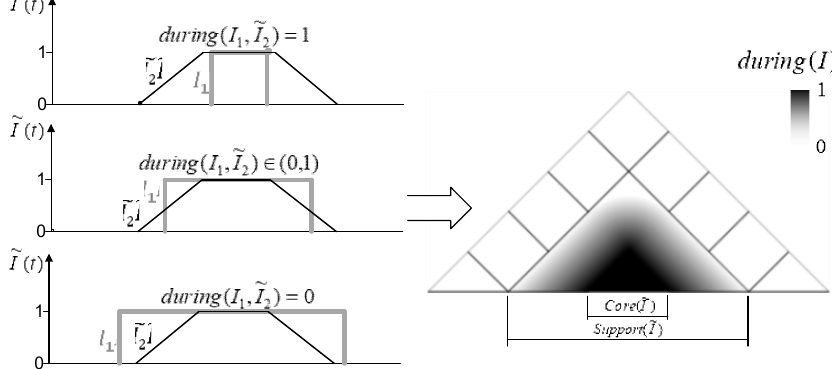
Figure 9. Representing the during relation to a fuzzy time interval (cid:101) I ( t ) in TM (adapted from Figure 9 . Representing the during relation to a fuzzy time interval 𝐼(cid:4634)(𝑡) in TM (adapted from [15]) Figure 9 . Representing the during relation to a fuzzy time interval 𝐼̃(𝑡) in TM (adapted from [15])